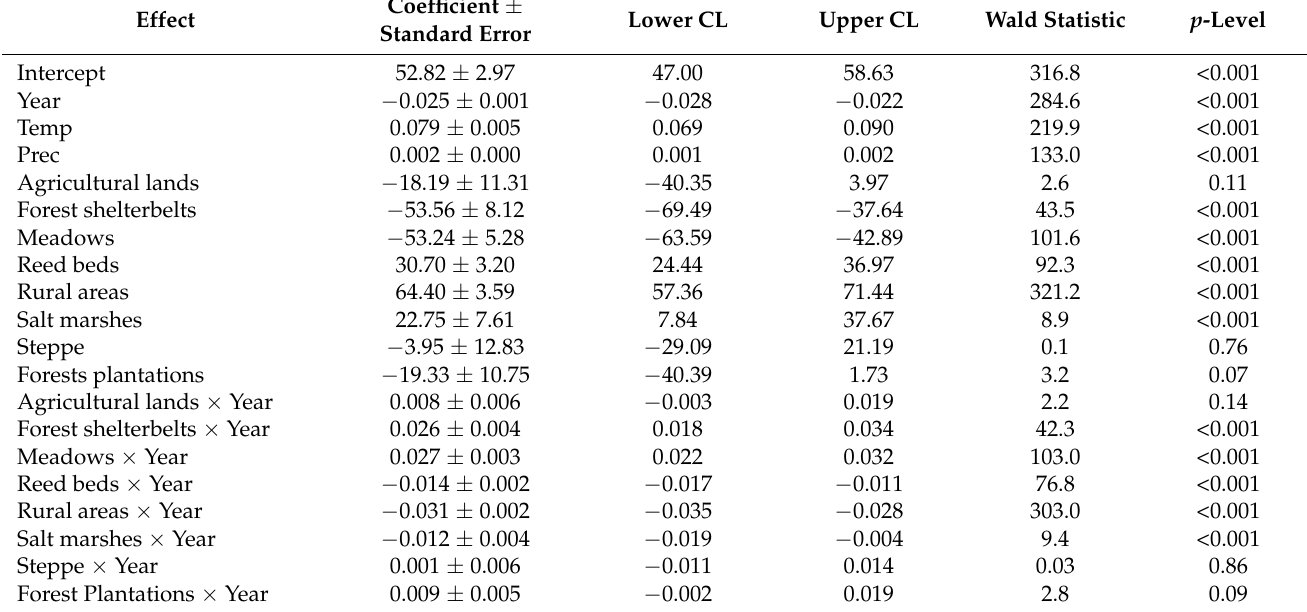
Table 4. Multiple generalized linear model of the effect of precipitation, temperature, time, and biotope type on bird community abundance (the estimates for factors represent differences from the median value for the metacommunity as a